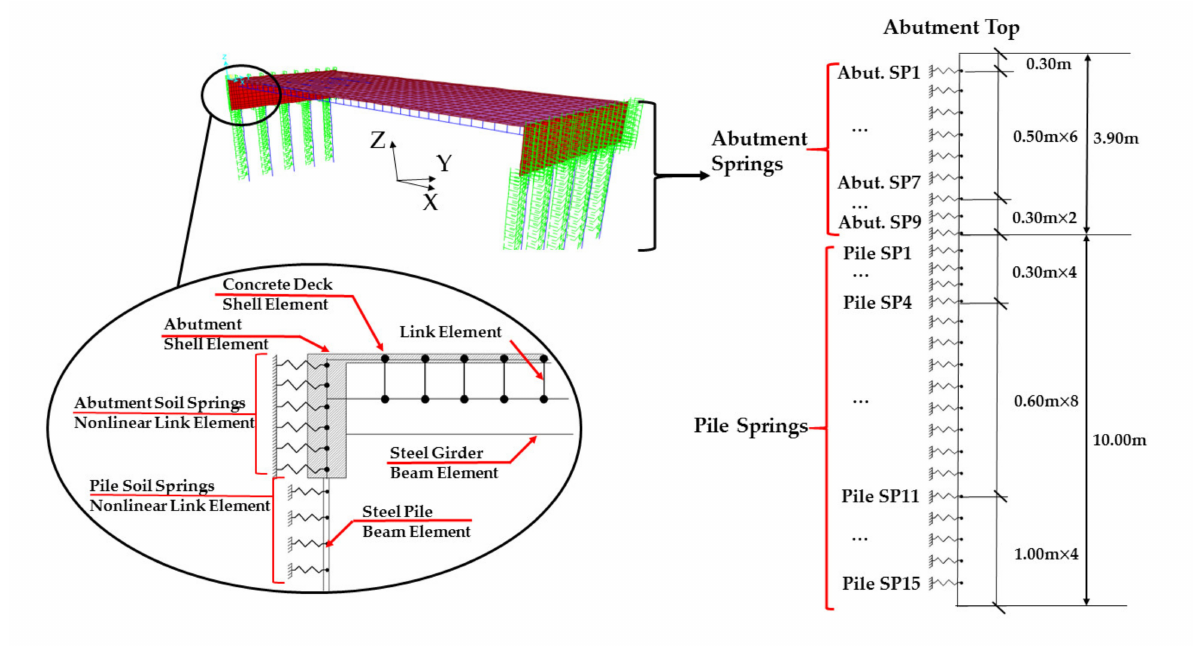
Figure 2. Finite element model of a skewed integral abutment bridge.